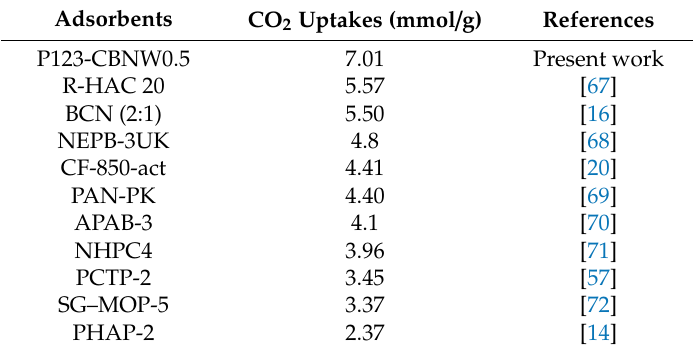
Table 4. Comparative study of CO 2 capture capacities of prepared sample with various adsorbents at 273 K and 1